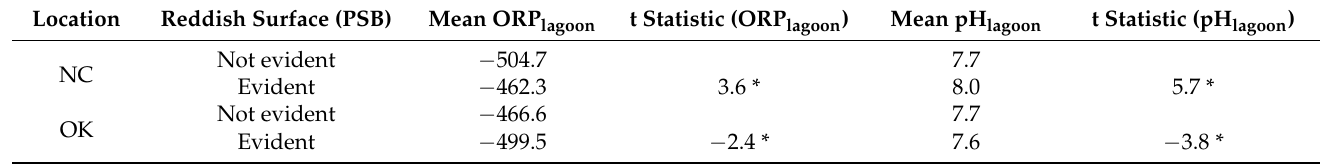
Table 3. In situ lagoon conditions at 0.3 m depth associated with PSB